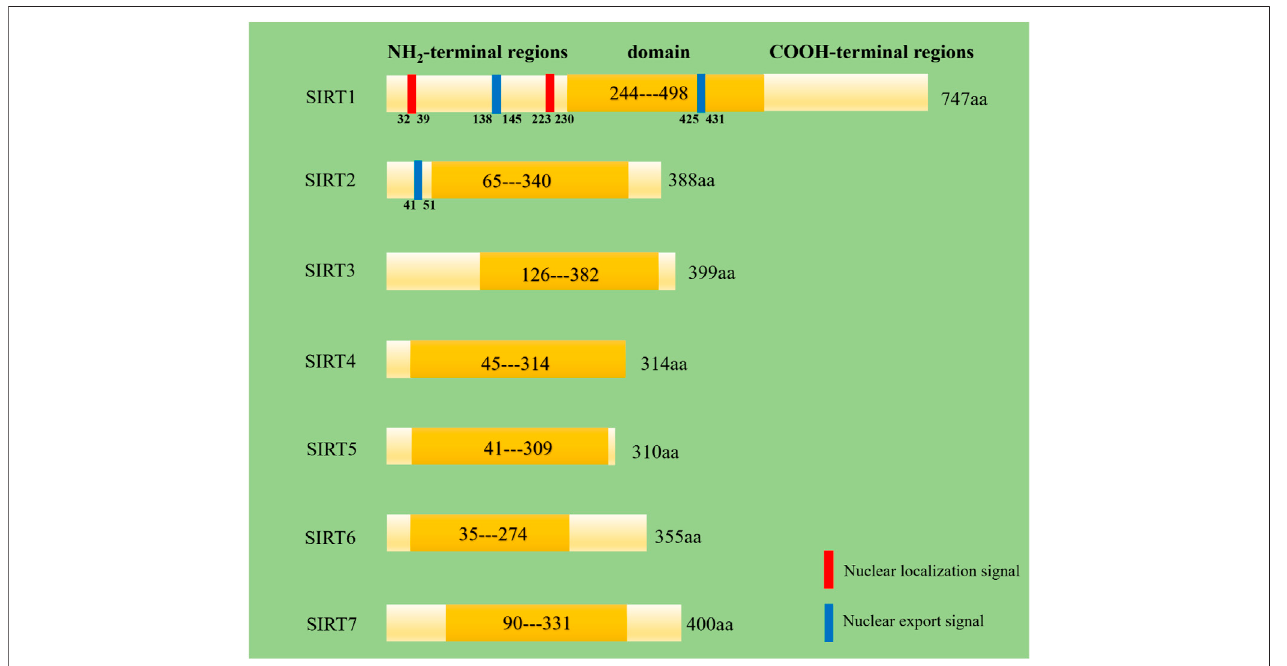
FIGURE2| SecondrystructuresofhumanSIRT1-7.Domainmeansaspeci fi ccombinationofsecondarystructuresorganizedintocharacteristicthree-dimensional structure or fold. These data come from the website http://www.uniprot.org/.